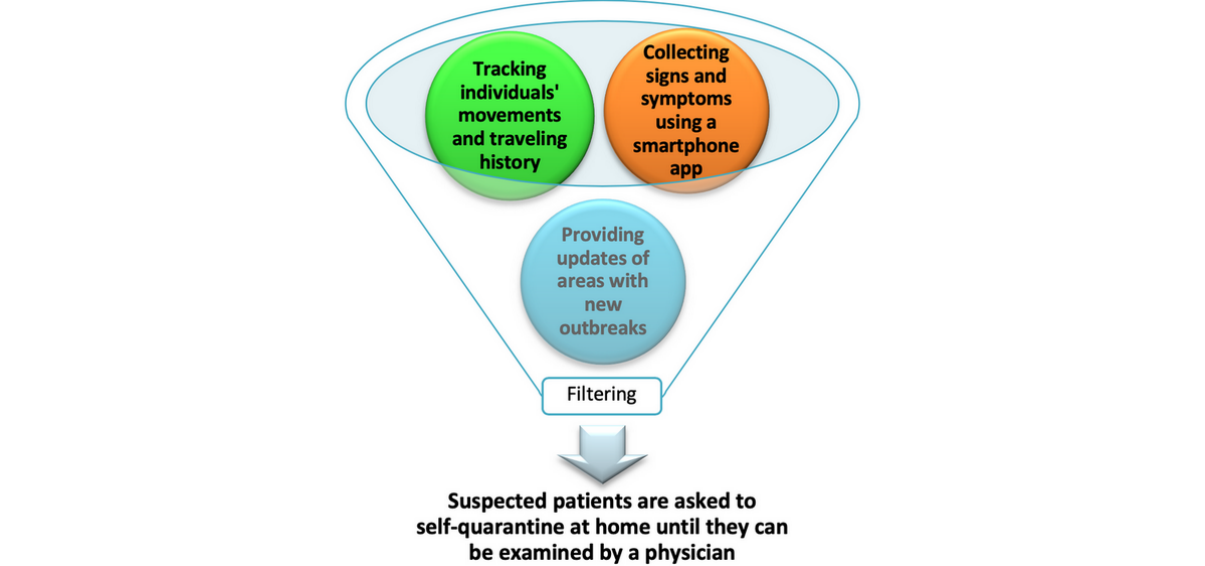
Figure 2. Potential artificial intelligence–based detection of suspected patients with coronavirus disease using a smartphone